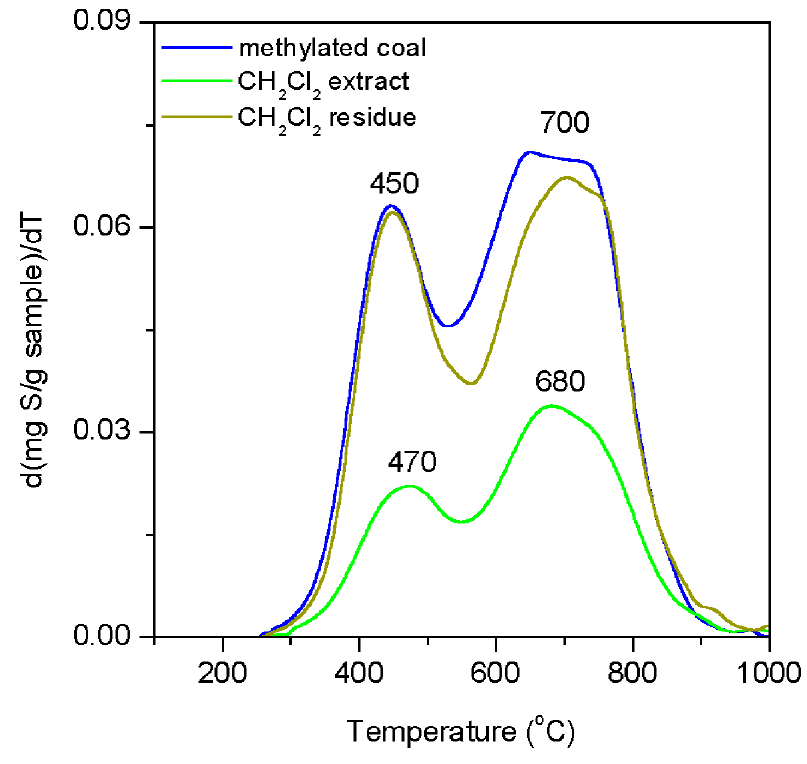
Fig. 7 AP-TPR kinetograms of Illinois No. 6 coal methylated by Liotta method and products of its